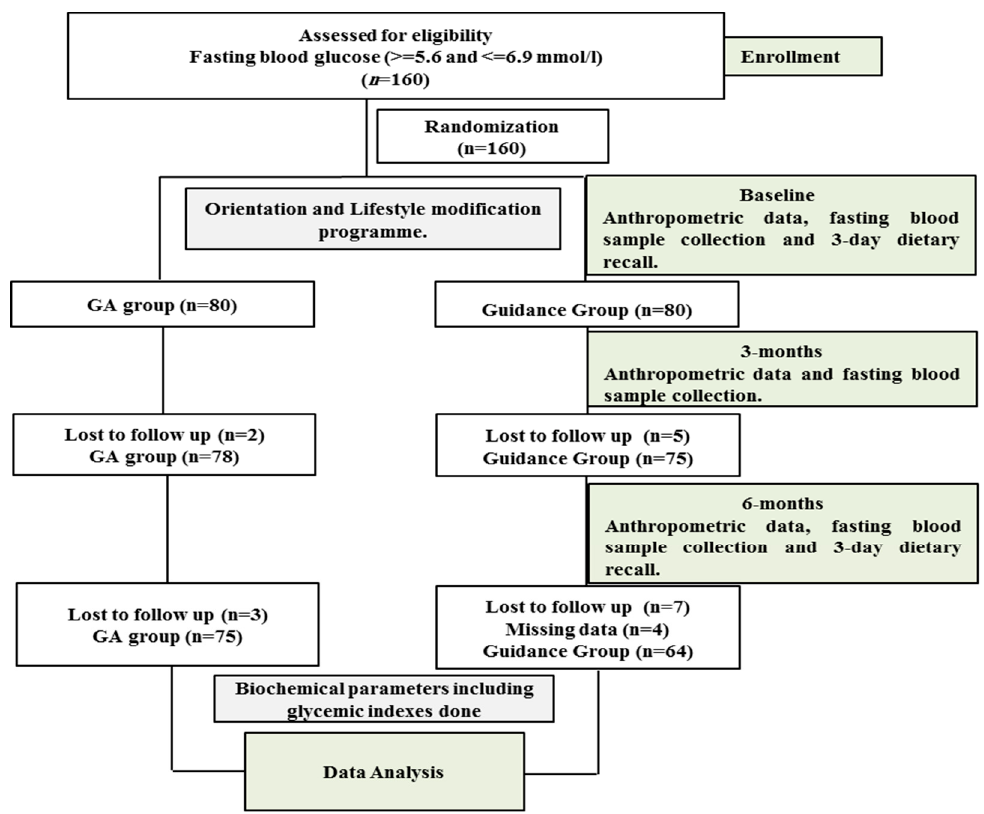
Figure 1. Flow chart detailing the participation of participants and their allocation to treatment groups.